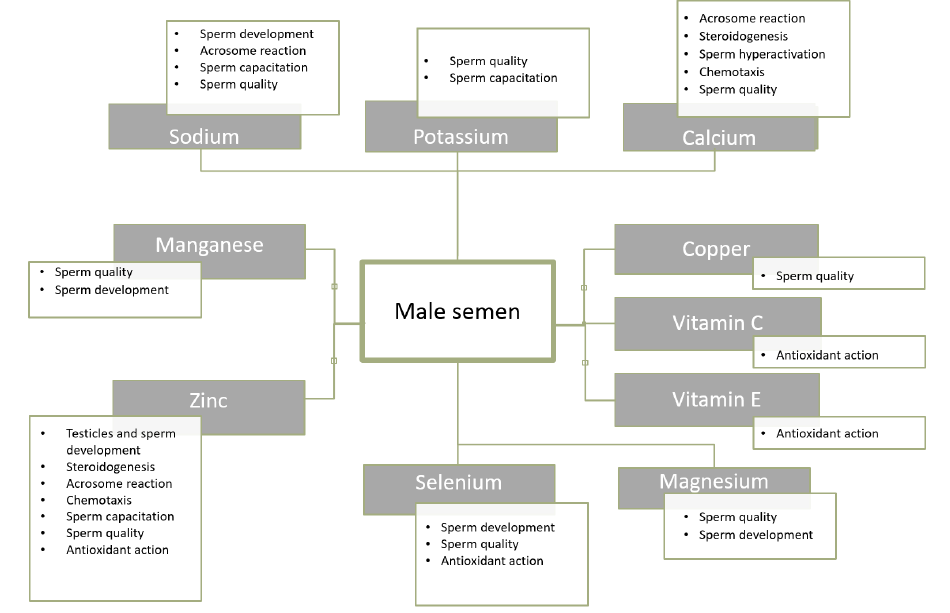
Figure 3. Selected components of male semen and their role [81].